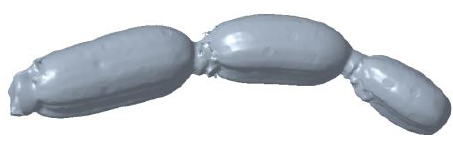
Figure 6. 3D model of the lotus root.